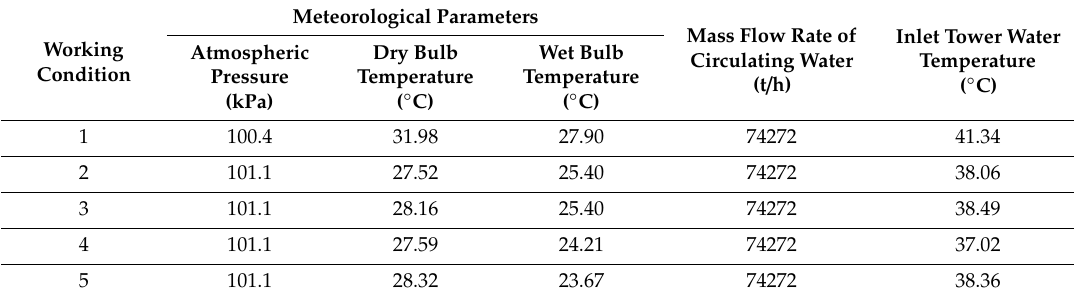
Table 5. Five di ff erent working conditions of 600 MW